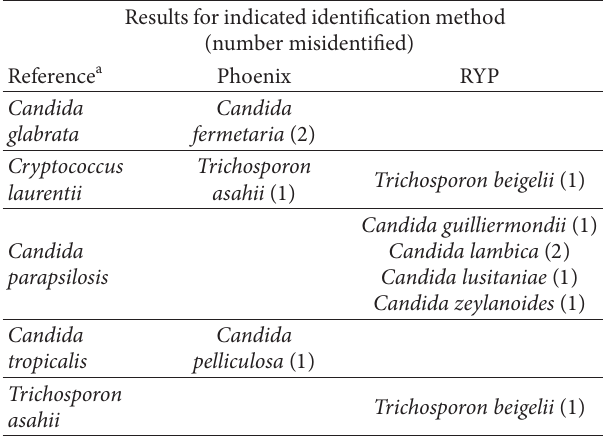
Table 2: Discrepant identifications by Phoenix and RYP systems for 10 yeast isolates. Results for indicated identification